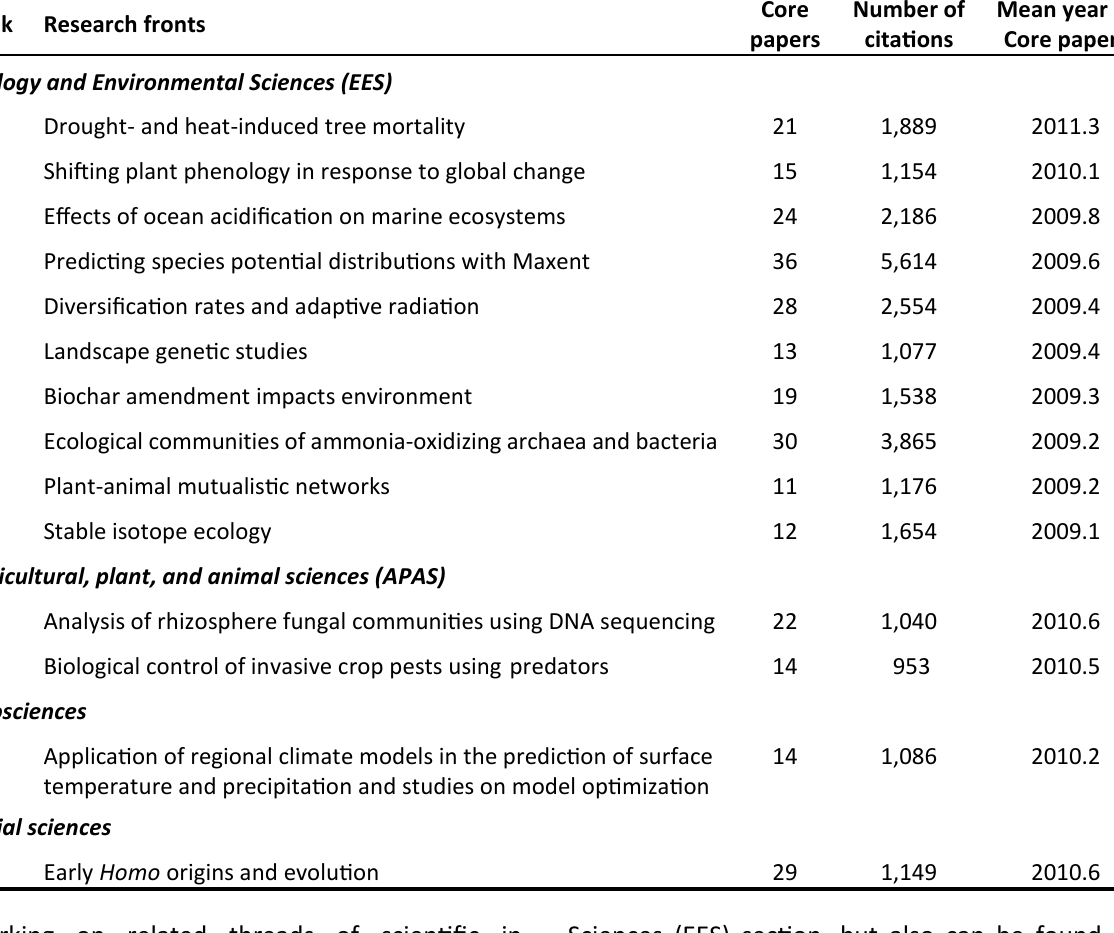
Table 1. Research Fronts for 2014 in Ecology and Environmental Sciences and in research areas related to biogeography, as identified by the Joint Research Center of Emerging Technology Analysis established by Thomson Reuters and the National Science Library, Chinese Academy of Sciences (JRCETA 2014). Other research categories in their analysis (i.e., clinical medicine, biological sciences, chemistry & materials science, physics, astronomy and astrophysics, and mathe- matics & computer science & engineering) did not include any research fronts obviously related to